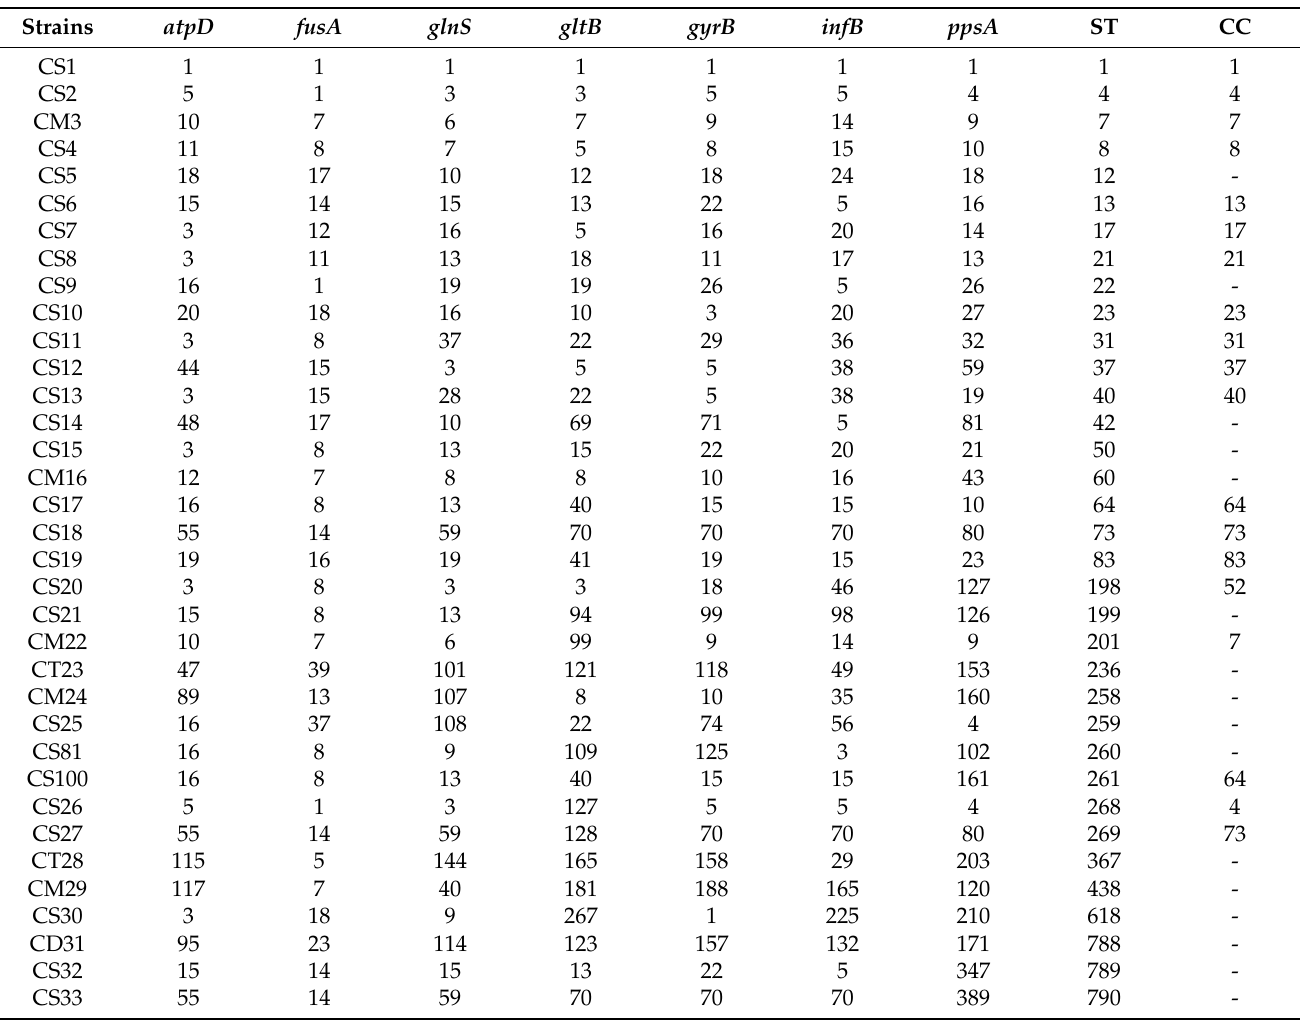
Table 2. MLST typing results of Cronobacter